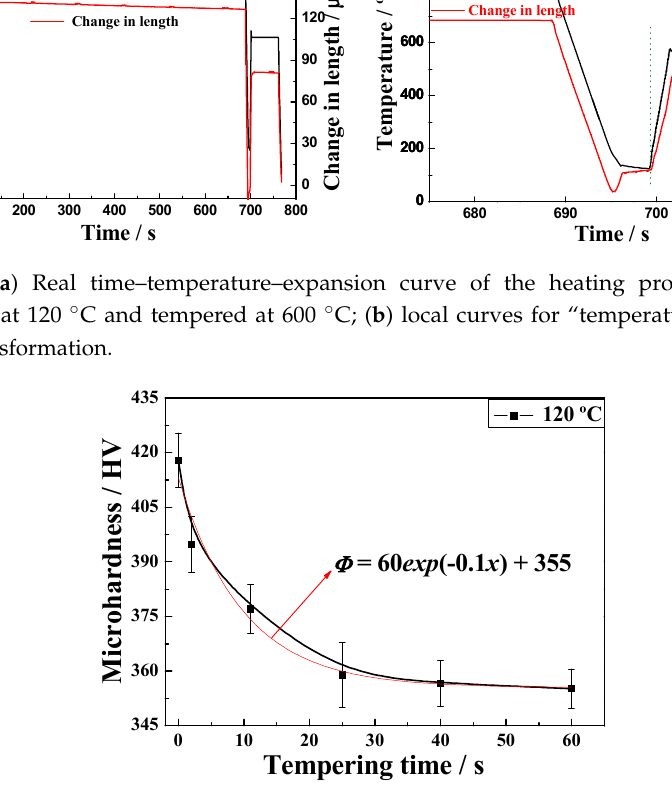
fourth step, i.e., ultrafast heating and annealing [19,29,31]. The first stage is rapid heating. Xing et al.